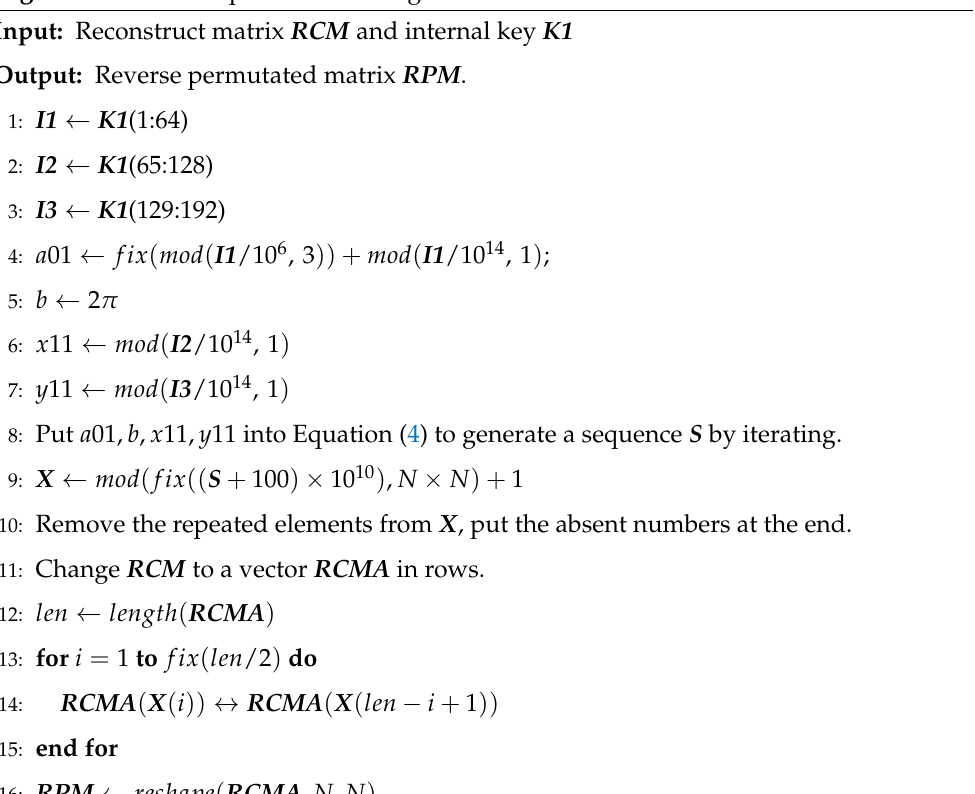
Algorithm 9 Reverse permutation I